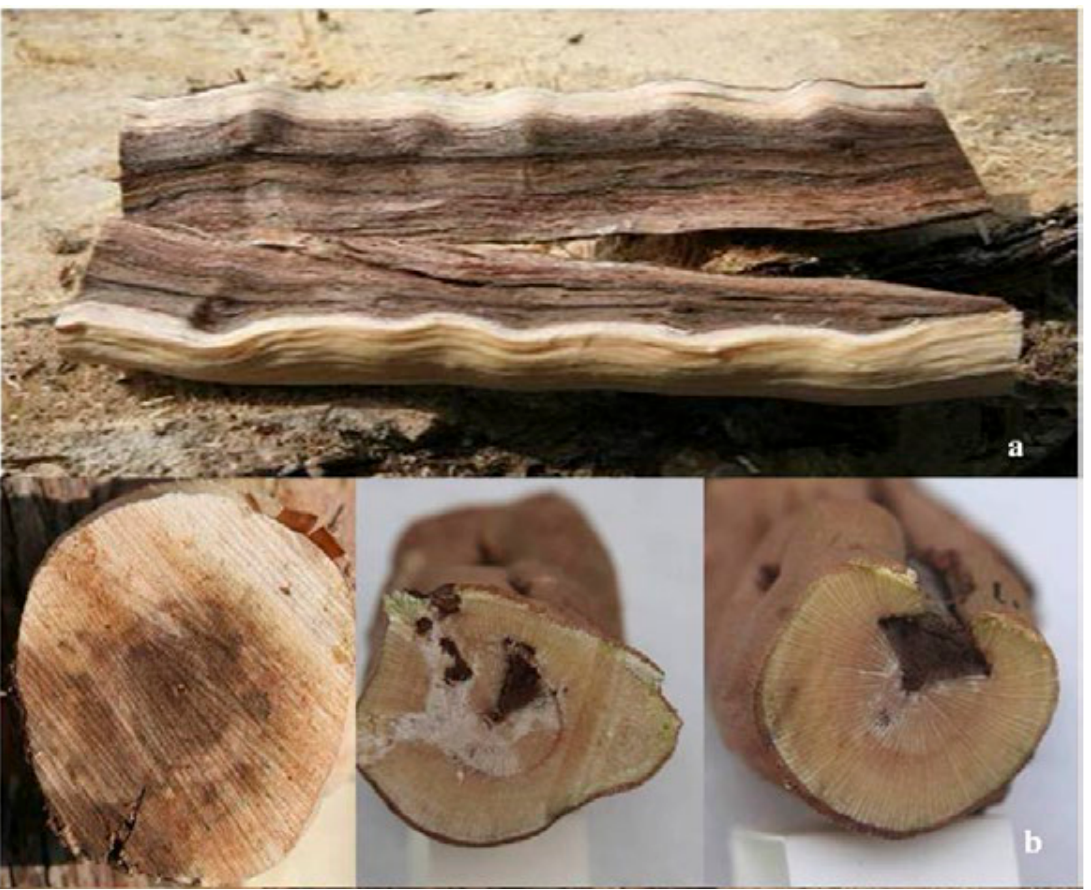
Figure 1. Symptoms of Botryosphaeria dieback observed in the trunk of a grapevine: a) sub-cortical, dark longitudinal bands observed when bark has been removed and b) in cross section, often